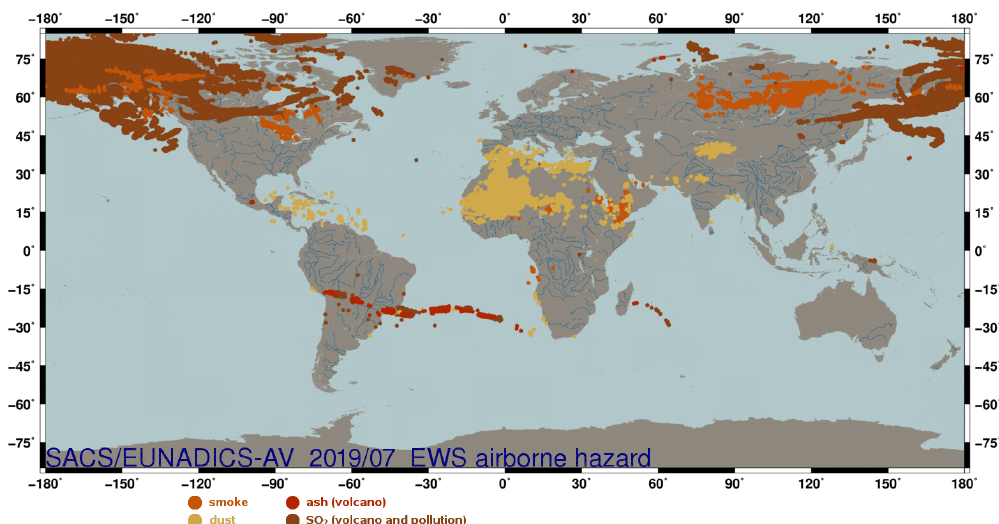
Figure 27. Selective detections of natural airborne hazards from the EUNADICS-AV EWS in July 2019 (Raikoke and Ubinas volcanic eruption, dust storms in the Sahara and Gobi deserts, and forest fires in Russia and Canada). Please note that the date format in this figure is